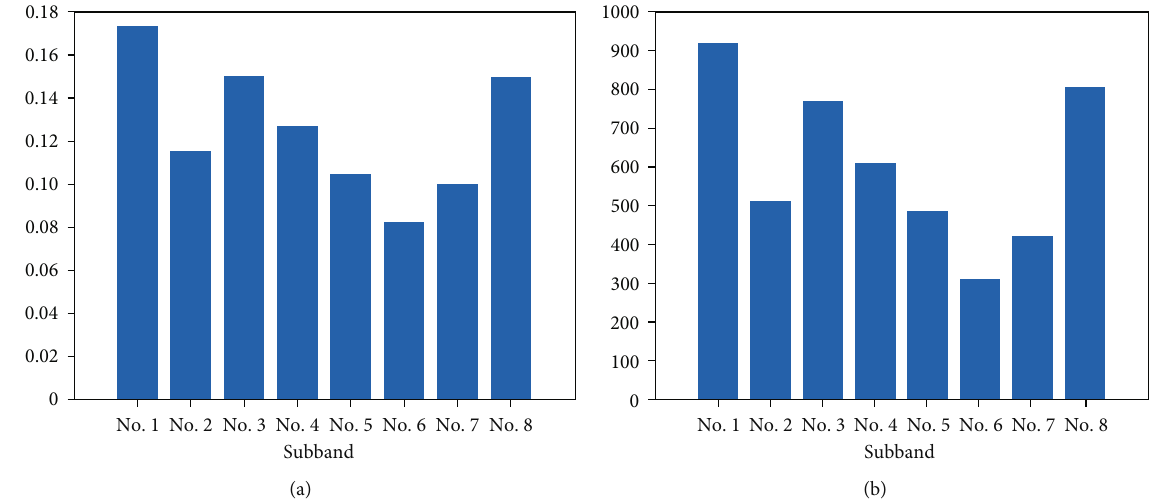
Figure 15: Wavelet decomposition subband energy ratio (a) and wavelet feature-scale entropy (b) of complete layer 3.